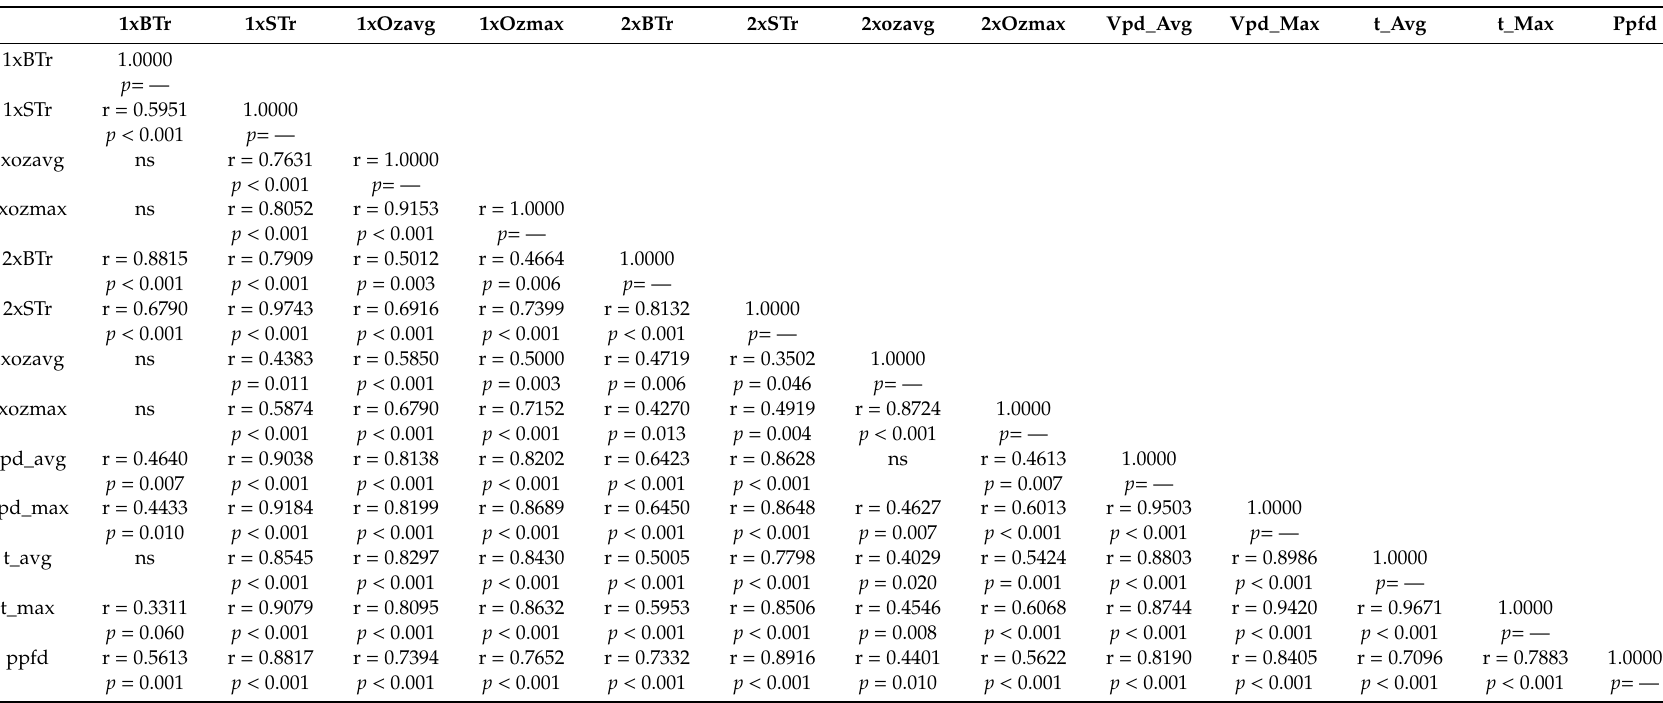
Table 3. Correlation coe ffi cient (r) and level of significance ( p ) in the correlation matrix among daily values of total transpiration in beech (BTr) and spruce (STr) and 10-min means of O 3 concentrations (ozavg), O 3 peaks (ozmax), vapour pressure di ff erence means (vpd_avg), vapour pressure deficit peaks (vpd_max), air